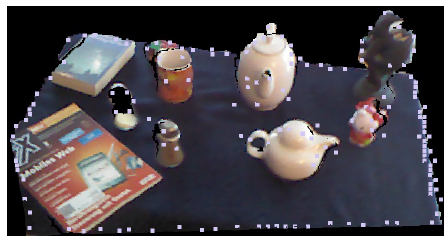
Figure 4: Point cloud with NARF keypoints